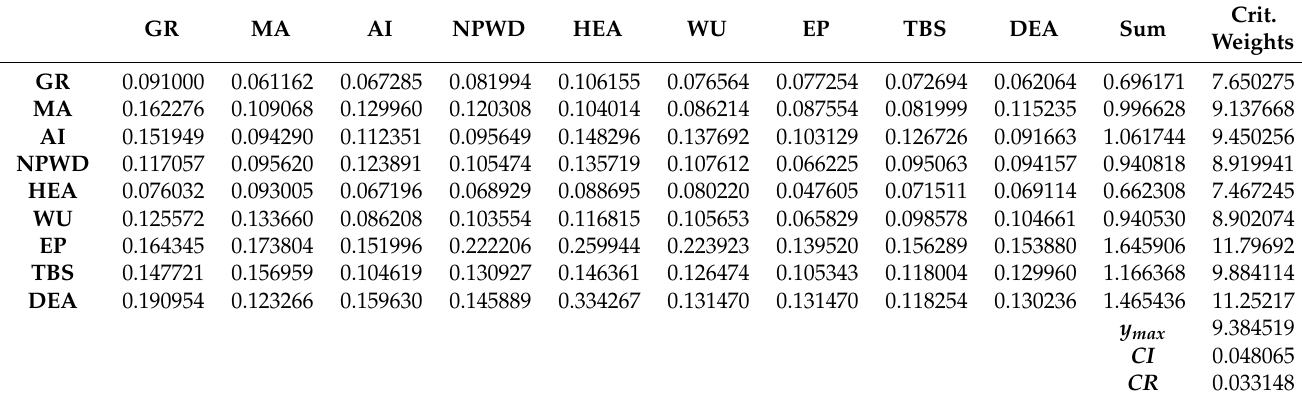
Table 6. Computation of CR and CI of vulnerability parameters for consistency of AHP.